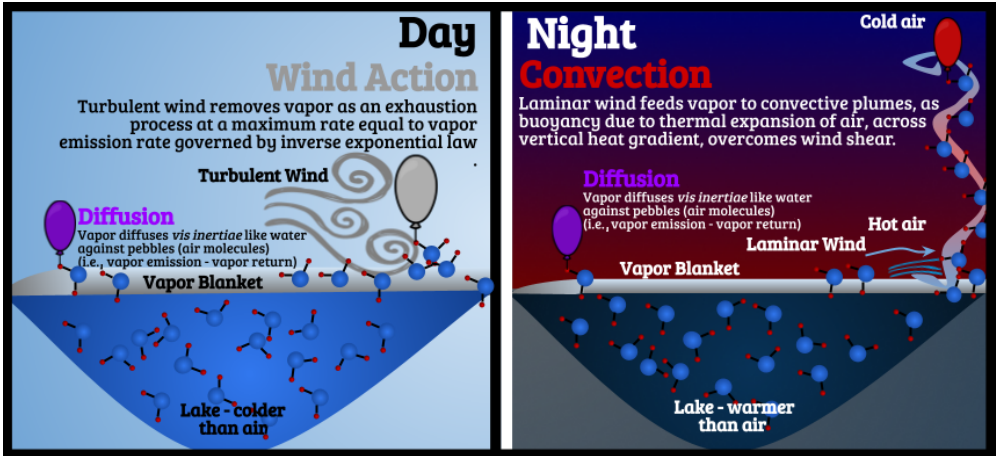
Figure 1. Horton’s understanding of the primary processes that control